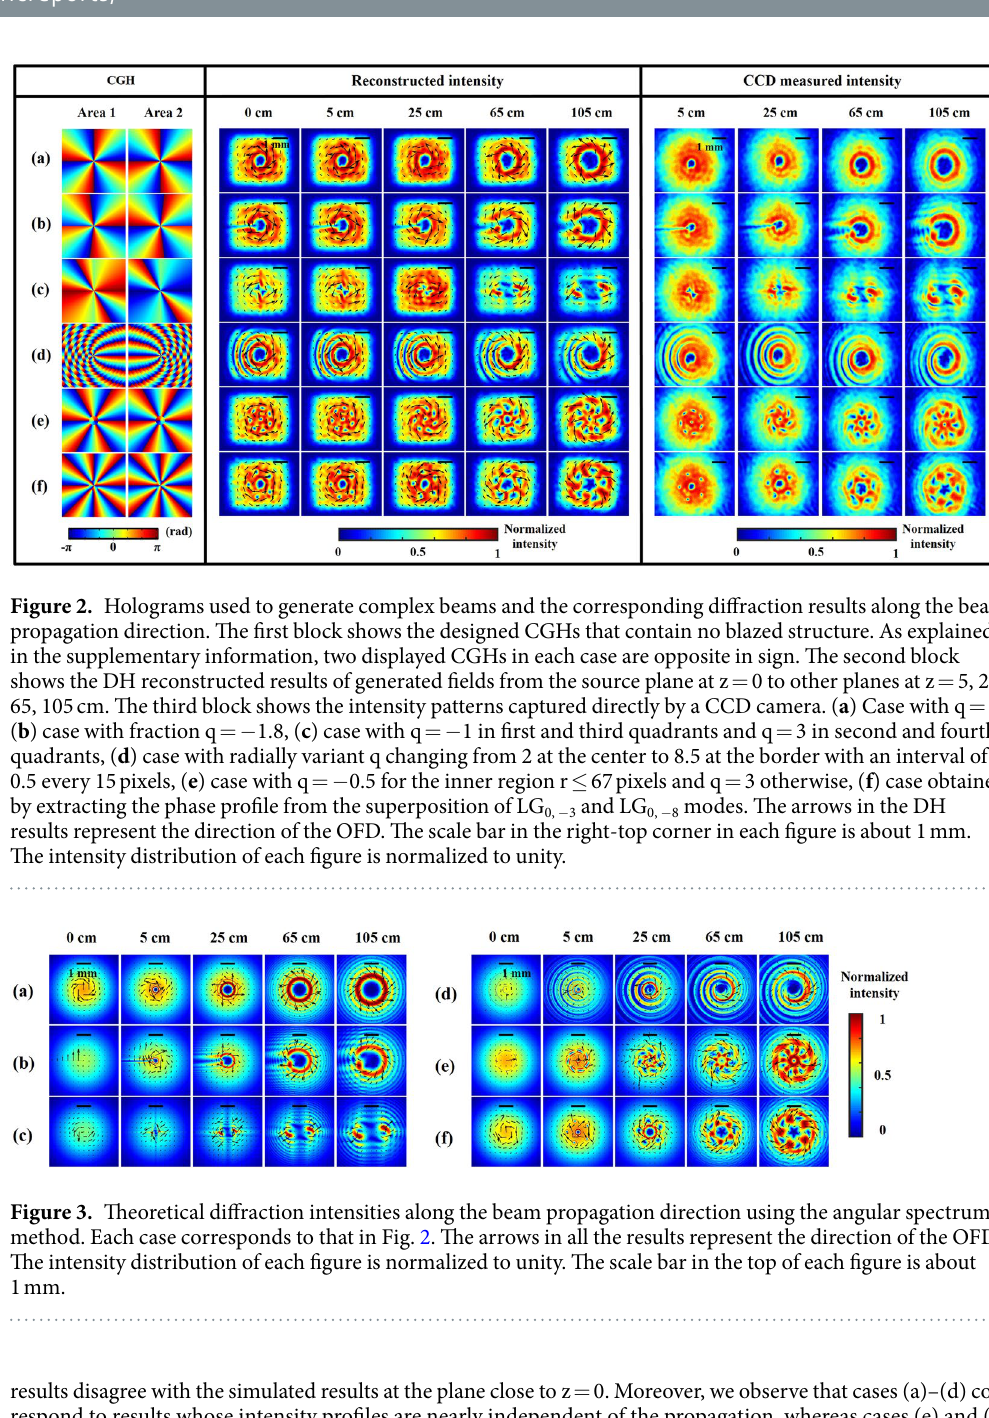
results disagree with the simulated results at the plane close to z = 0. Moreover, we observe that cases (a)–(d) cor- respond to results whose intensity profiles are nearly independent of the propagation, whereas cases (e) and (f) are dependent on the propagation. This may be attributed to the local fields that do not satisfy the paraxial wave condition on the transverse plane diffract more strongly away from the beam axis compared to fields that satisfy the paraxial wave condition. Specifically, this happens in a situation where there are evenly distributed phase singularities located at the same radial distance from the beam center (see Fig. 4). As expected, beams that change their intensity profiles as they propagate will finally become stable after propagating for a long distance. To further understand the evolution of intensity profiles, Supplementary Video 1 shows an animation of the evolution of the intensity profiles with propagation. Figure 4 shows the light spatial phase distributions of the x component, where the reconstruction phase is referred to as the wrapped phase bounded between − π and π . Here, we omit discussions of the y components on the basis that the y component is simply π /2 out of phase with the x component for a LCP wave (recalling that the incident object beam in our experiment is RCP, and thus the output wave is LCP). As we can see, there is very good agreement between the theoretically predicted results and the DH reconstructed results, except that they may differ from an overall constant phase factor, which is unimportant for most purposes. Moreover, all the reconstructed phase distributions resemble those of holograms displayed on the SLM, especially at plane z = 0.